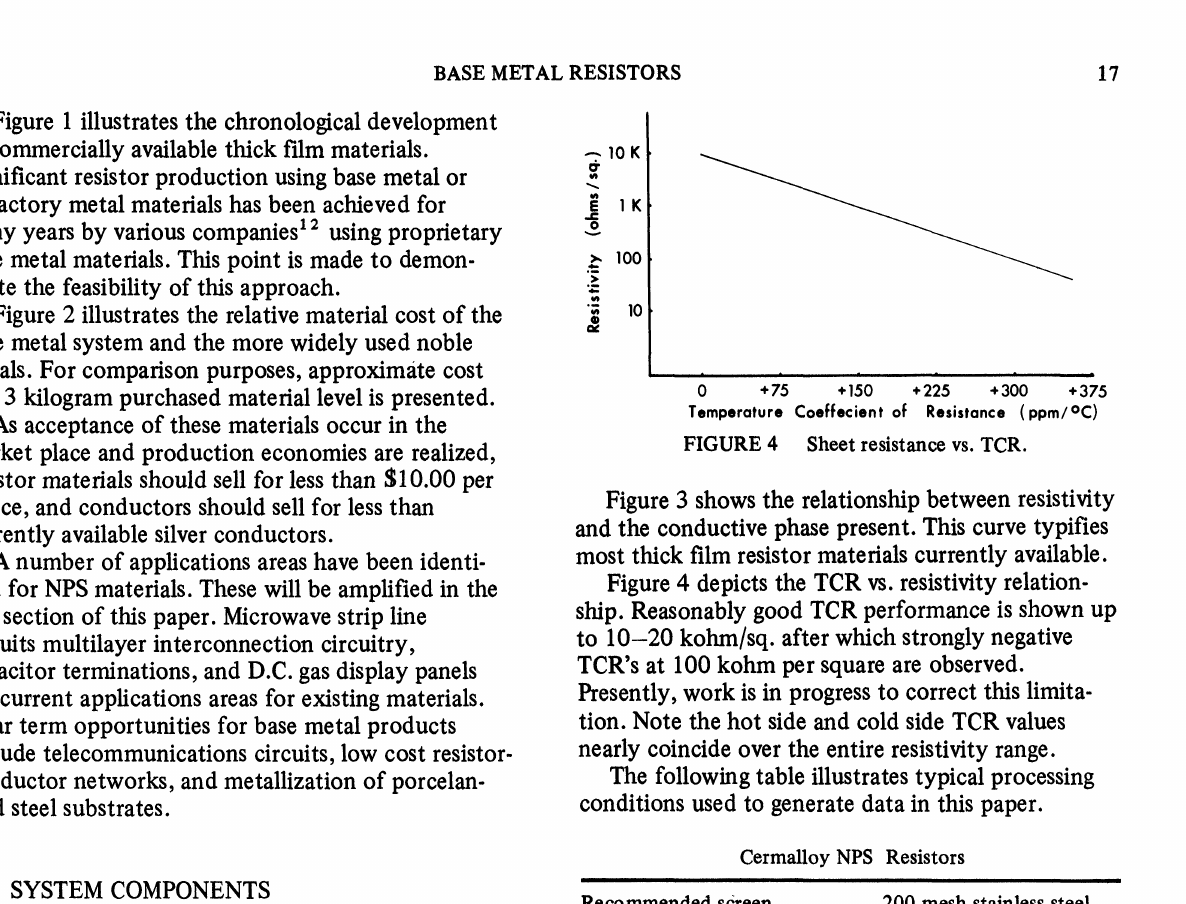
FIGURE 4 Sheet resistance vs. TCR.